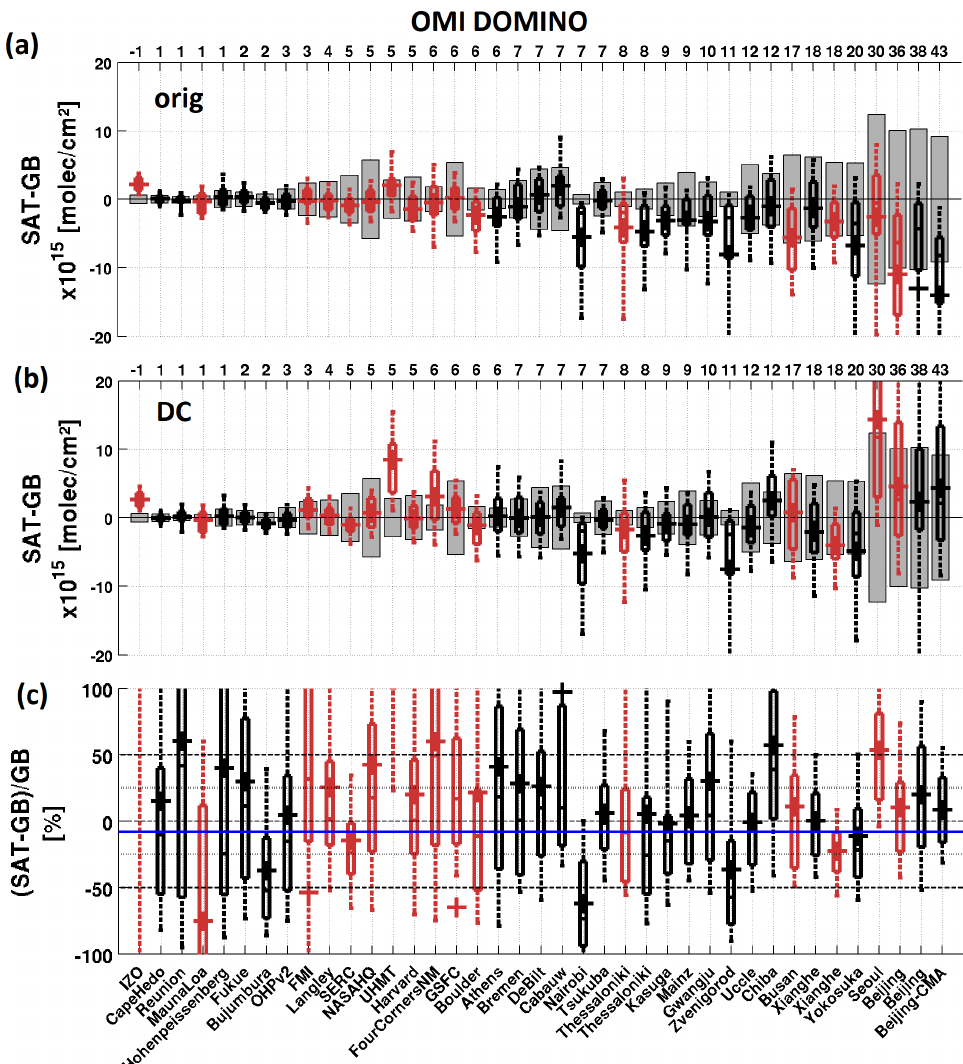
Figure 14. Box-and-whisker plot of the daily OMI TEMIS/DOMINO v2.0 biases for each station (a) for the original comparisons and (b, c) when correcting for the dilution effect, in absolute and relative values. MAX-DOAS stations are presented in black; direct sun stations in dark red. The stations are ordered by increasing values of the ground-based VCDtropo, and corresponding values are given on the upper horizontal axis. The box-and-whisker plots are defined as in Fig. 7. In (a, b) , grey bars are the ± comparison error, calculated adding in quadrature the satellite and ground-based VCDtropo errors.